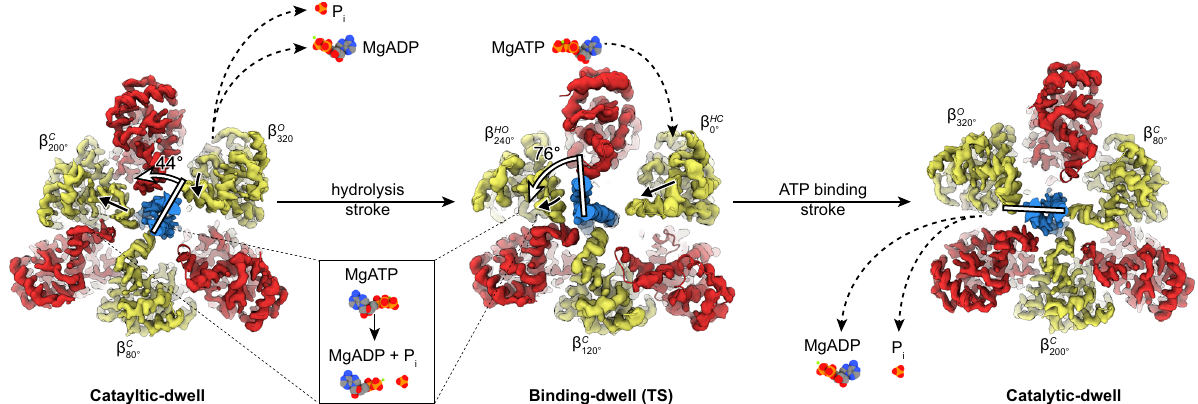
Fig. 7 Molecular basis of F 1 -ATPase substepping. The 120° rotation of the γ -subunit is achieved by two successive steps. Black dashed arrows depict nucleotide/P i exchange in that dwell state, solid black arrows depict β -subunit movements during following stroke, and white bars with arrows depict movement of γ -subunit during following stroke. The hydrolysis stroke occurs after the catalytic dwell; MgATP is hydrolyzed to MgADP + P i in the β C 200 (cid:1) site, resulting in its opening to a half-open state so that the γ -subunit is pulled towards the β C site and pivots around the β C subunit with a 44° rotation, 200 (cid:1) 80 (cid:1) MgADP and P i are exchanged for MgATP in the β O site, which reorients to a half-closed state primed for the ATP-binding stroke. The ATP-binding stroke 320 (cid:1) occurs after the binding-dwell (TS); MgATP is tightly bound by the β HC site, closing to a closed state, and β HO opens to and open state, with the γ -subunit 0 (cid:1) 240 (cid:1) being is pushed towards the β HO site, pivoting 76° around the β C TP ð Þ 240 (cid:1) 80 (cid:1) Methods Protein puri fi cation . JM103 Δ unc E. coli cells harboring the expression plasmid for PS3 F 1 -ATPase (subunits α , β and δ , with a 6× His tag on β and the temperature- sensitive β E190D mutation) were incubated at 37 °C with 170r.p.m. shaking